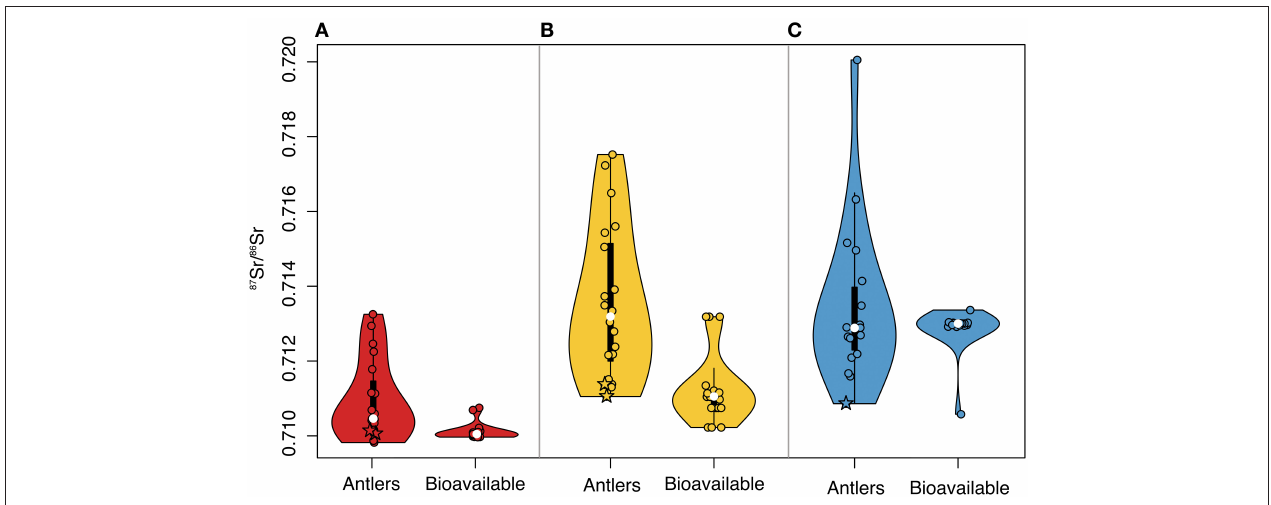
FIGURE 5 | Violin plots showing distributions of female antler 87 Sr/ 86 Sr and estimated bioavailable 87 Sr/ 86 Sr of each antler location for the (A) Western, (B) Central, and (C) Eastern Coastal Plain. Plots illustrate kernel density estimates (violin boundaries), interquartile range (thick vertical bars), 1.5 times the interquartile range (thin vertical line), and median (white point). Antler and bioavailable 87 Sr/ 86 Sr (points) are offset to aid visibility. Stars identify 87 Sr/ 86 Sr for antlers grown prior to 1900CE.